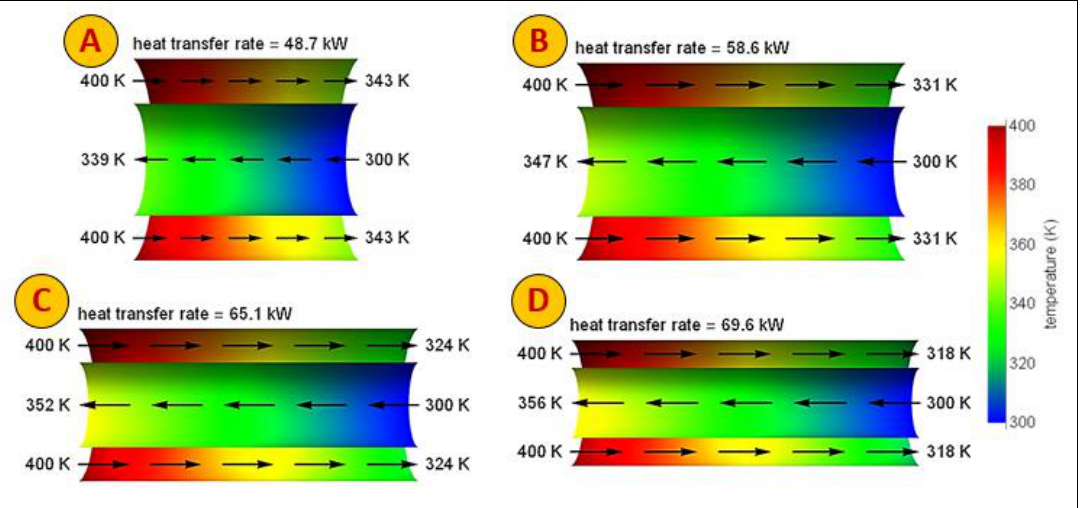
Figure 6. Counter HE with length of (A), 10 m (B), 15 m (C), 20 m, and (D) 25 m